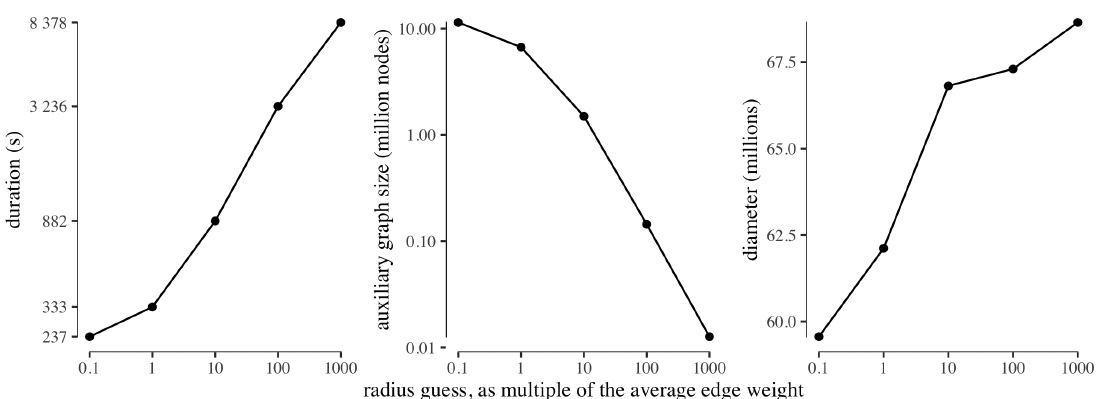
Figure 5. Time employed to build clusterings of USA with different radius guesses ( left ), size of the auxiliary graph for each guess ( center ), and diameter approximation obtained from each clustering ( right ). All axes are in logarithmic scale, except for the y axis of the rightmost